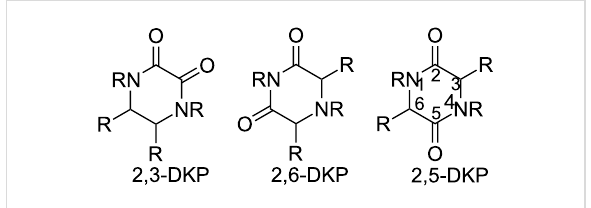
Figure 1: The three structural isomers of diketopiperazines. The 2,5- DKP isomer is most common.